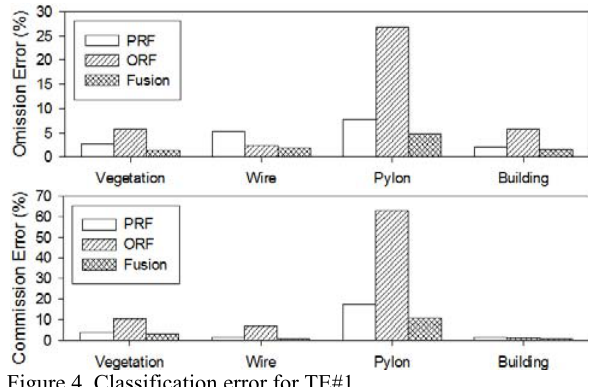
Figure 4. Classification error for TE#1